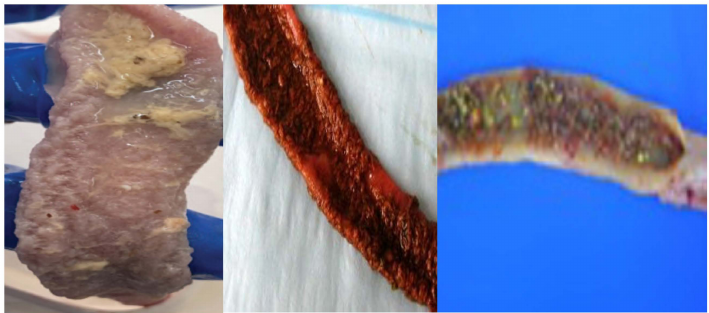
Figure 1. Damage of intestinal epithelia due to necrotic enteritis. Adapted from